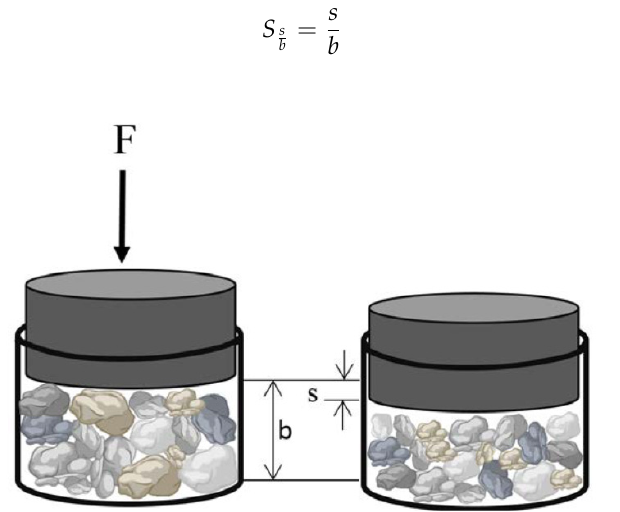
Figure 2. Illustration of interparticle breakage, before and after the compression.